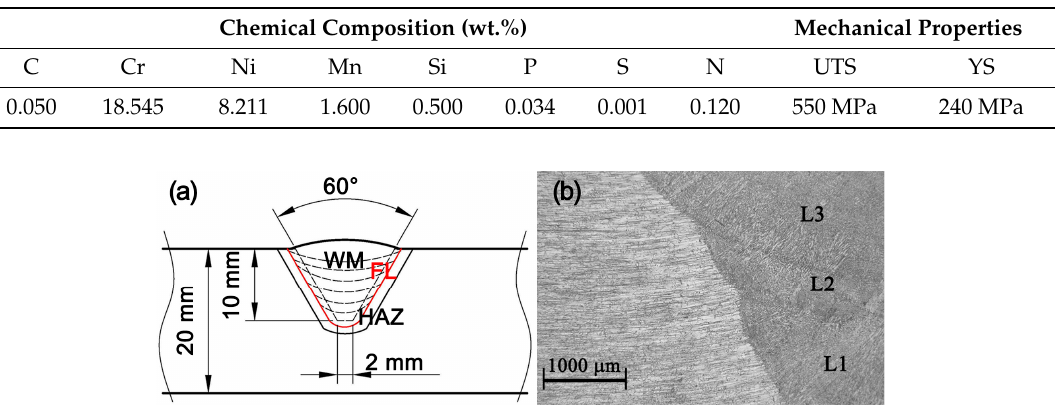
Figure 1. Profiles of the welding joint: ( a ) welding groove geometry; and ( b ) macro-image of cross section cover the HAZ. Table 2. Welding process parameters used for thermal cycling measurement of the HAZ. Bead No.